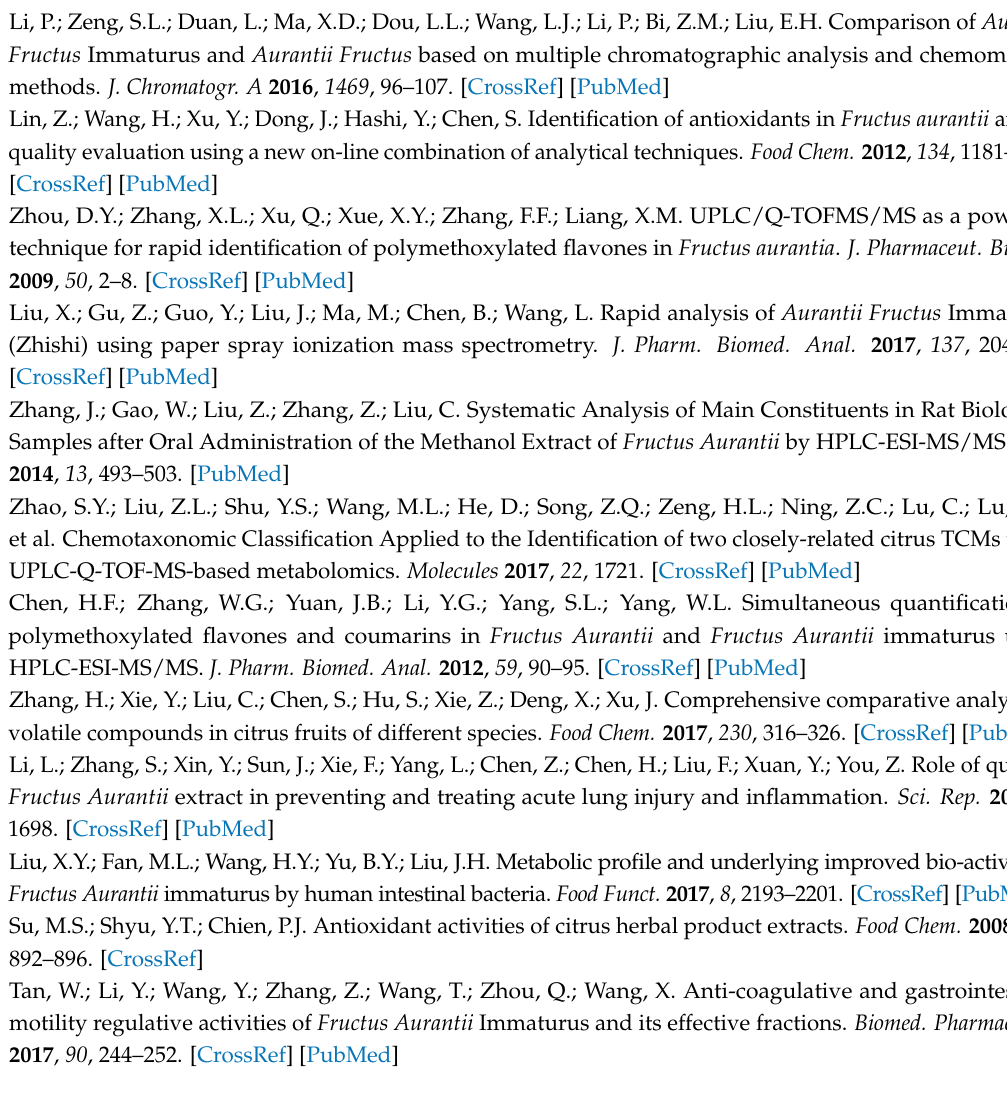
s1, Figure S1: Structures of 86 compounds form ethanol extract of Aurantii fructus . Figure S2: Structures of 18 compounds in volatile oils of Aurantii fructus . Table S1: 11 samples of Aurantii fructus obtained from different habitats. Table S2: Contents of chemical markers in Aurantii fructus from11 different samples (mg/g). Author Contributions: Y.H., H.X. and Q.T. conceived and designed the experiments; Y.H., Z.L., W.W., Y.S., Y.C., performed the experiments and designed the figures; Y.H., Z.L., Y.S. and Y.C. analyzed and helped in